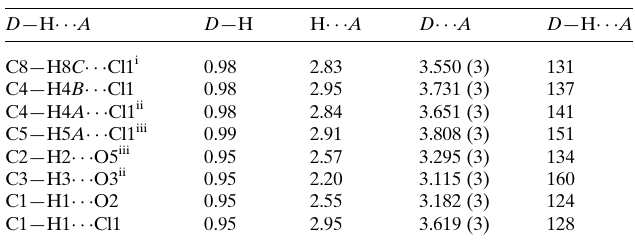
Table 2 Hydrogen-bond geometry (A˚ , (cid:5) ) for 1 .